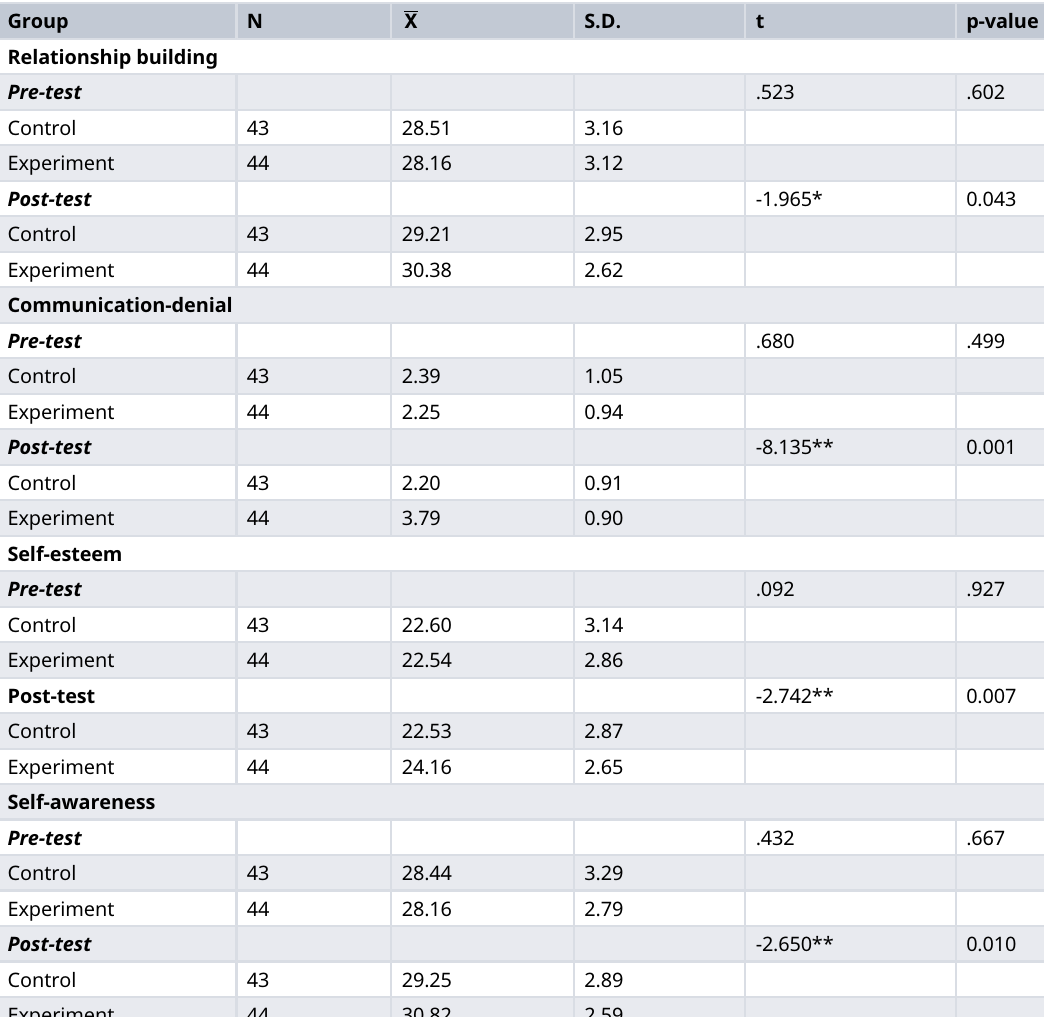
Table 2. Mean and independent-samples t-test of the four variables after the intervention between the control group and the experimental group. Group N X S.D.